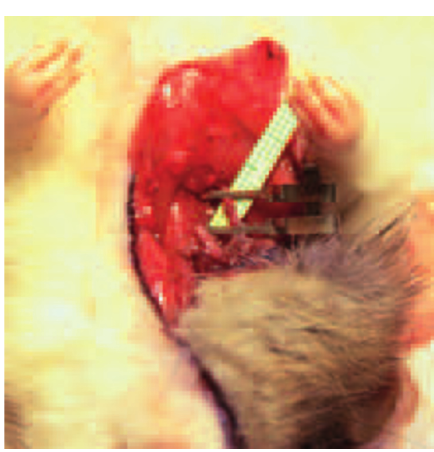
Figure 7. Jugular veins anastomoses Figure 6. Jugular veins anastomoses